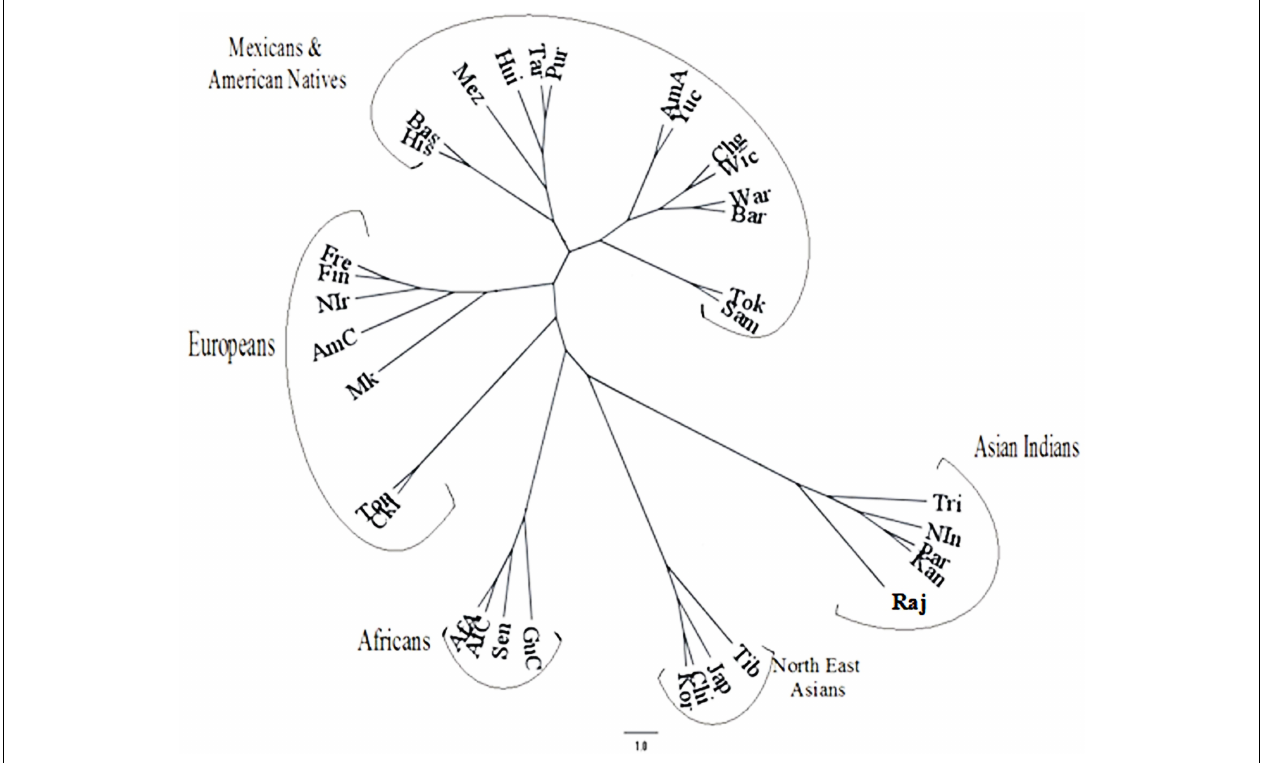
FIGURE 3 | Phylogenetic dendrogram based on REML analysis of the KIR genotypic profiles in the Rajbanshis and other previously studiedWorld populations (adopted from Guha etal., 2013).